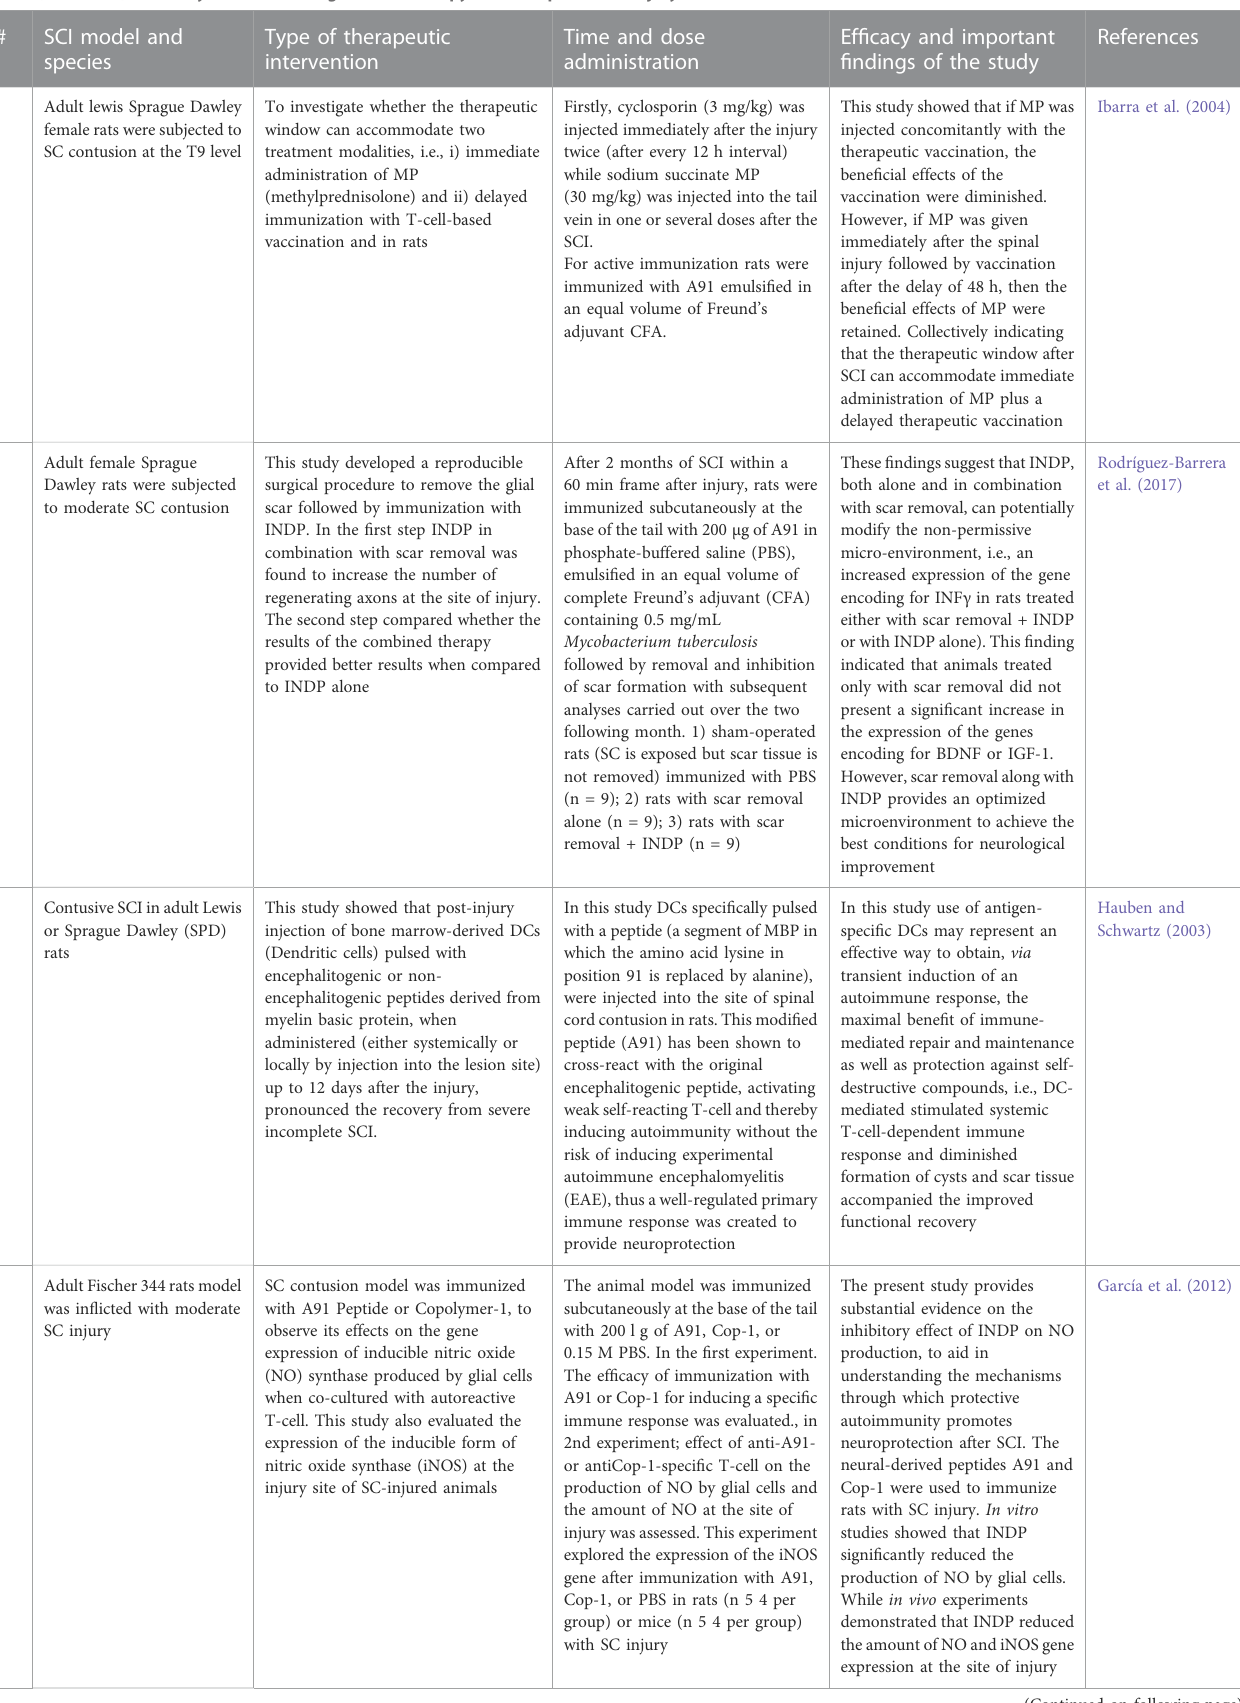
TABLE 1 ( Continued ) Summary of studies using immunotherapy to treat spinal cord